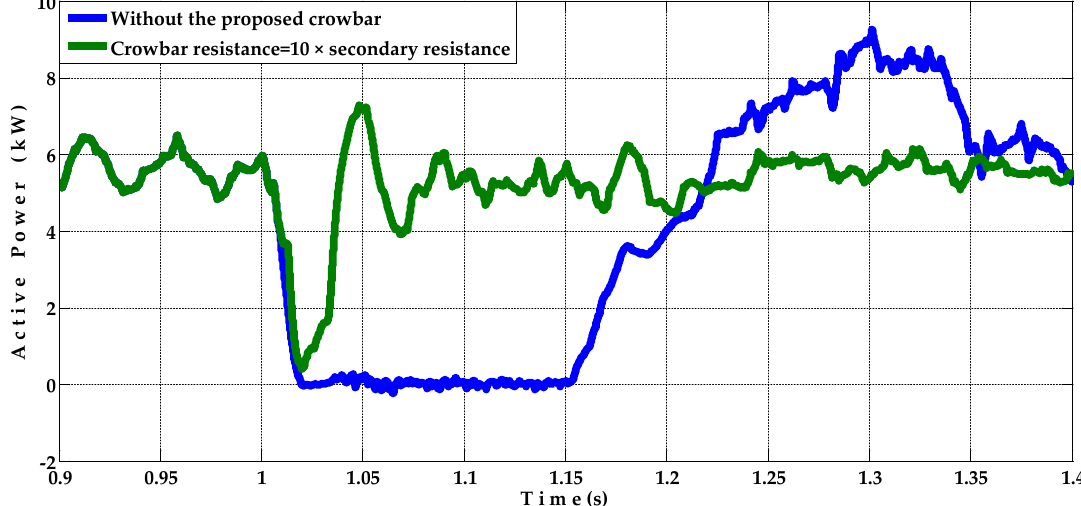
Figure 6. Active power of BDFRG with and without the proposed crowbar under symmetrical fault occurrence.